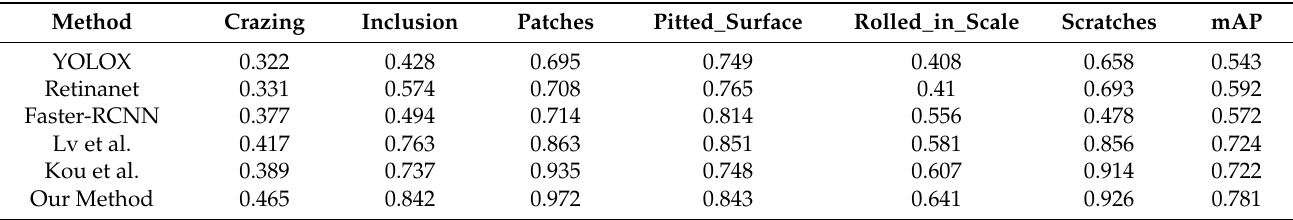
Table 4. Performance of different models on the steel surface defect